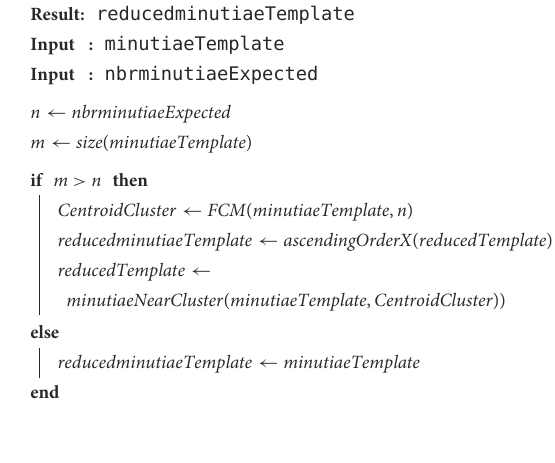
Algorithm 5. k-means-based method.